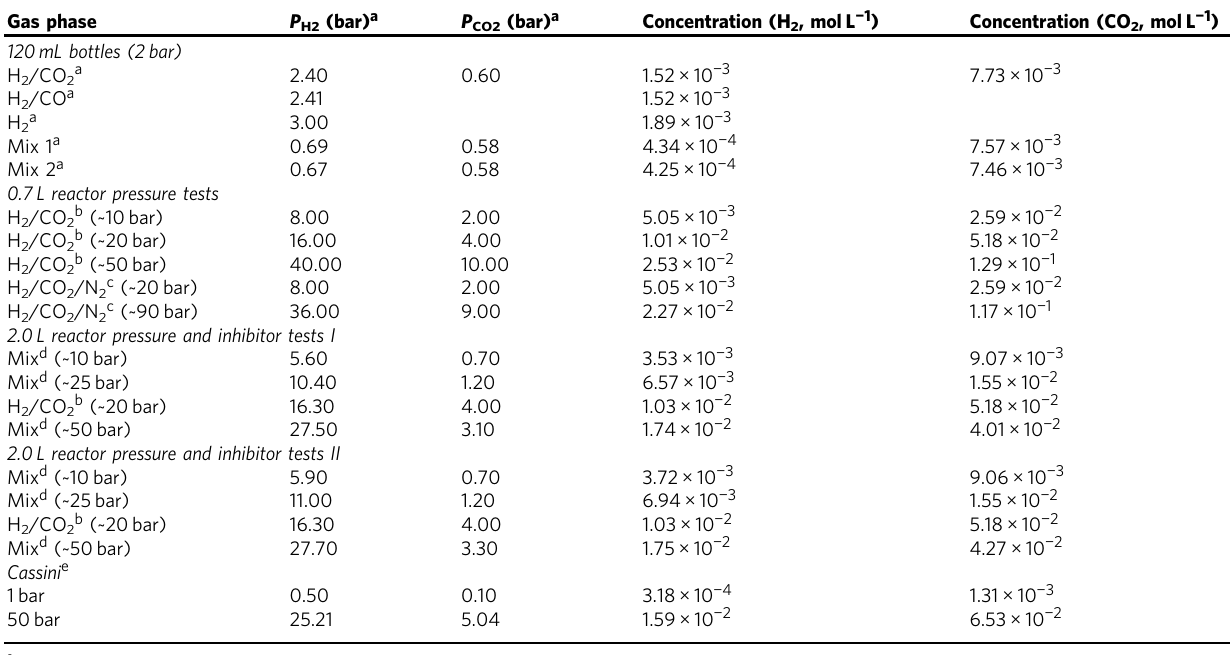
a Detailed composition of the gases can be found in Table 2 b For the H 2 /CO 2 experiments a ratio of 4:1 was applied c For the